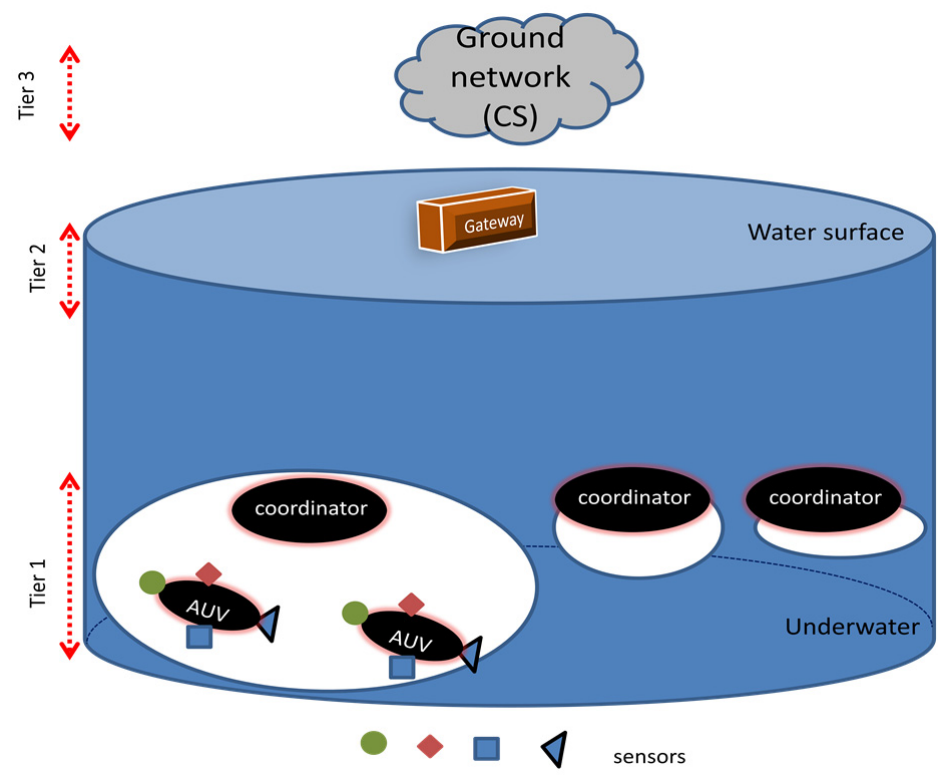
Figure 1. Schema of the three tier system